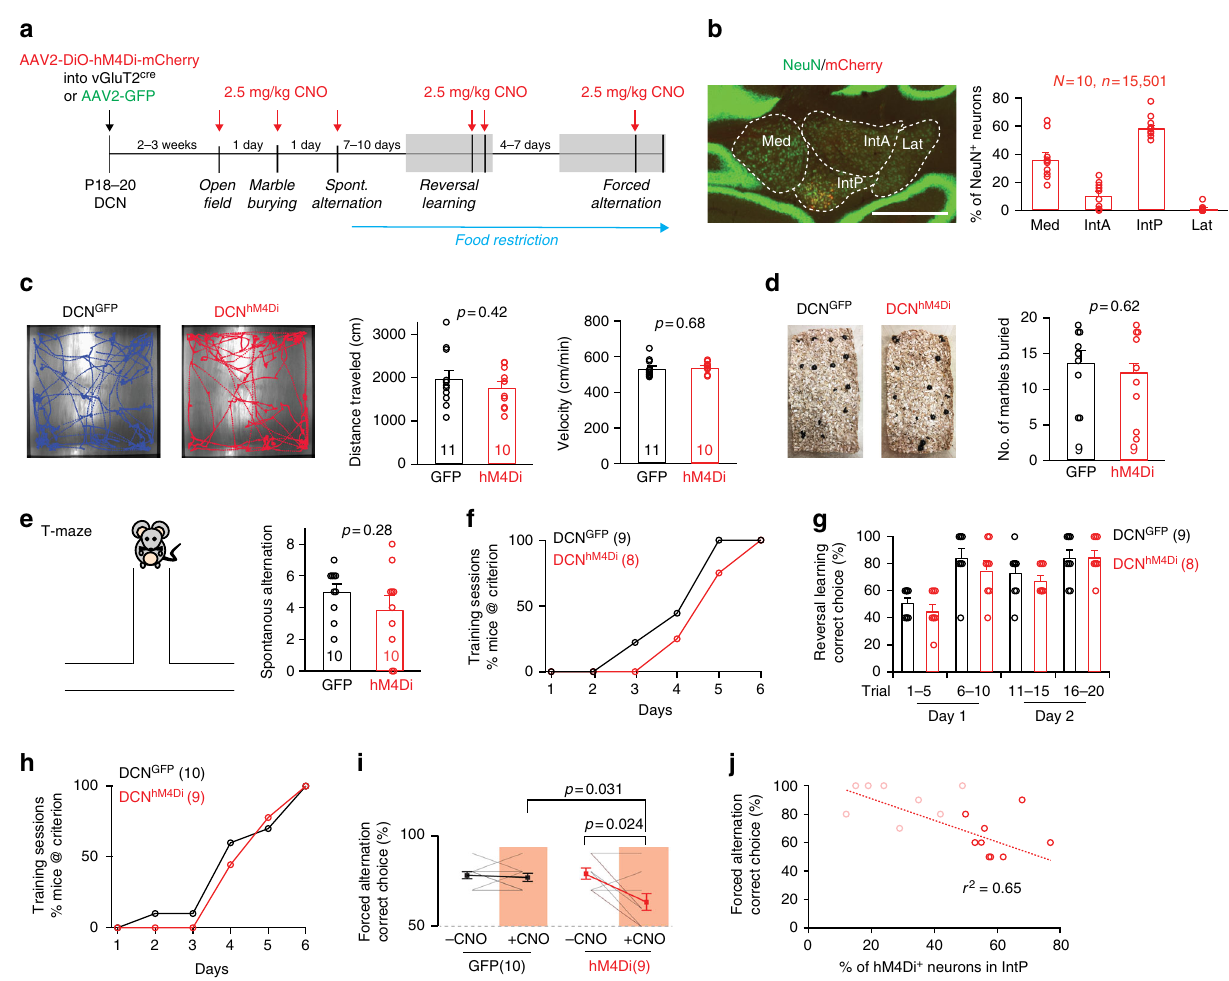
Fig. 6 DCN neuron activity is required for goal-directed behaviors. a Stereotaxic injection and analysis scheme. b Left: Example image of AAV-DiO-hM4Di infection site in DCN of vGluT2-cre mice. Right: Quanti fi cation of hM4Di-positive neurons in each DCN subnucleus ( N = 10 mice, mean ± SEM). Scale bar: 400 µ m. c Open fi eld tracks of control DCN GFP and hM4Di-expressing DCN hM4Di treated CNO. Right: Quanti fi cation of distance traveled in open fi eld and velocity. ( N = 11 and 10 mice, respectively; mean±SEM, unpaired t -test). d Left: example images of marble burying test. Right: number of marbles buried by DCN GFP and DCN hM4Di mice treated with CNO ( N = 9 mice per group, mean ± SEM, unpaired t-test). e Left: Cartoon for T-maze test. Right: Number of spontaneous alternations observed in 10 consecutive trials in a T-maze without food reward. ( N = 10 mice per group, mean ± SEM, unpaired t -test). f T- maze reversal learning. Mice were food-deprived and trained in a rewarded T-maze paradigm to choose one arm. Percentage of mice reaching the training criterion after each day is plotted ( N = 9 DCN GFP and N = 8 DCN hM4Di mice). g T-maze reversal learning. Percentage of correct choice at Day1 and Day 2 after reversal of the rewarded side. For each day, the fi rst 5 and second 5 trials are plotted separately to differentiate perseverative errors ( p = 0.325, unpaired t-test) and regressive errors ( p = 0.347, unpaired t -test; N = 9 DCN GFP and N = 8 DCN hM4Di mice, mean ± SEM). h T-maze forced alternation. The percentage of mice reaching the training criterion after each day is plotted. ( N = 10 DCN GFP and N = 9 DCN hM4Di mice). i T-maze forced alternation. Performances at the last training session (-CNO) and the session after CNO treatment ( + CNO) are compared. For comparison between DCN GFP and DCN hM4Di mice after CNO, mean ± SEM, Mann – Whitney test, two tailed. For comparison of DCN hM4Di mice before and after CNO, mean ± SEM, Mann – Whitney test, two tailed ( N = 10 DCN GFP and N = 9 DCN hM4Di mice). j Correlation of the percentage of hM4Di-positive neurons in IntP and the performance in the forced alternation task after CNO treatment in DCN hM4Di mice. Each circle represents one animal. Thick-lined circles represent mice with >50% of IntP neurons expressing hM4Di. Thin-lined circles are mice not included (<50% of IntP neurons, N = 8